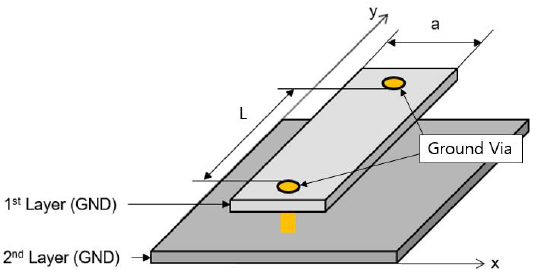
Figure 6. Conceptual diagram of a structure using two ground layers.